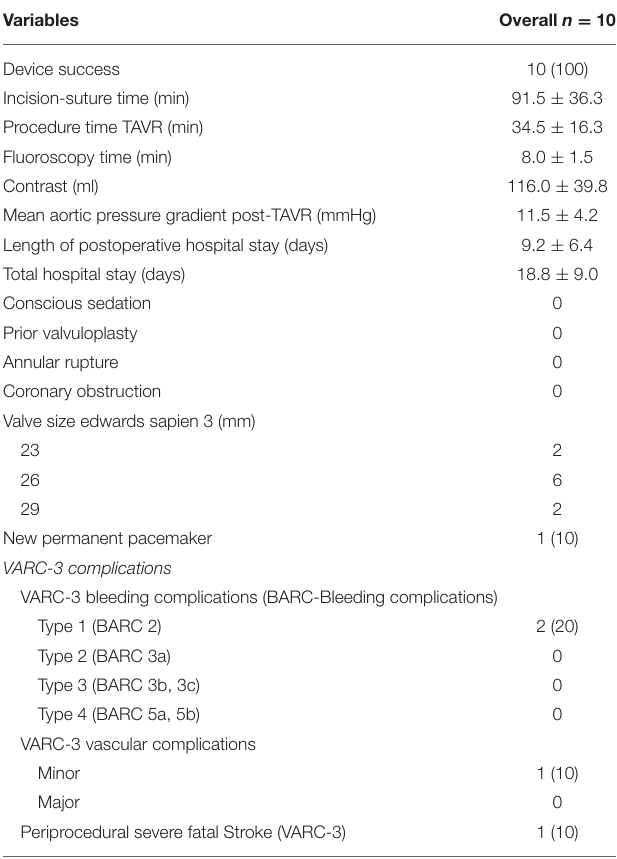
TABLE 2 | Procedural details and adverse